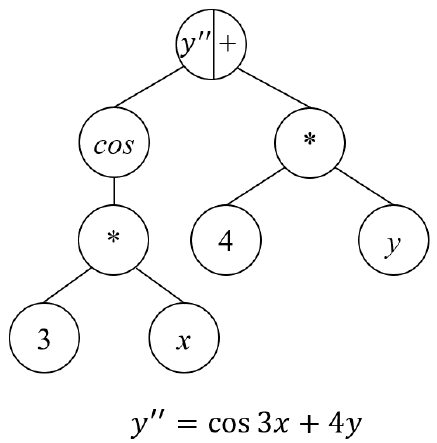
Figure 1. Example of the ODE encoded as a tree.